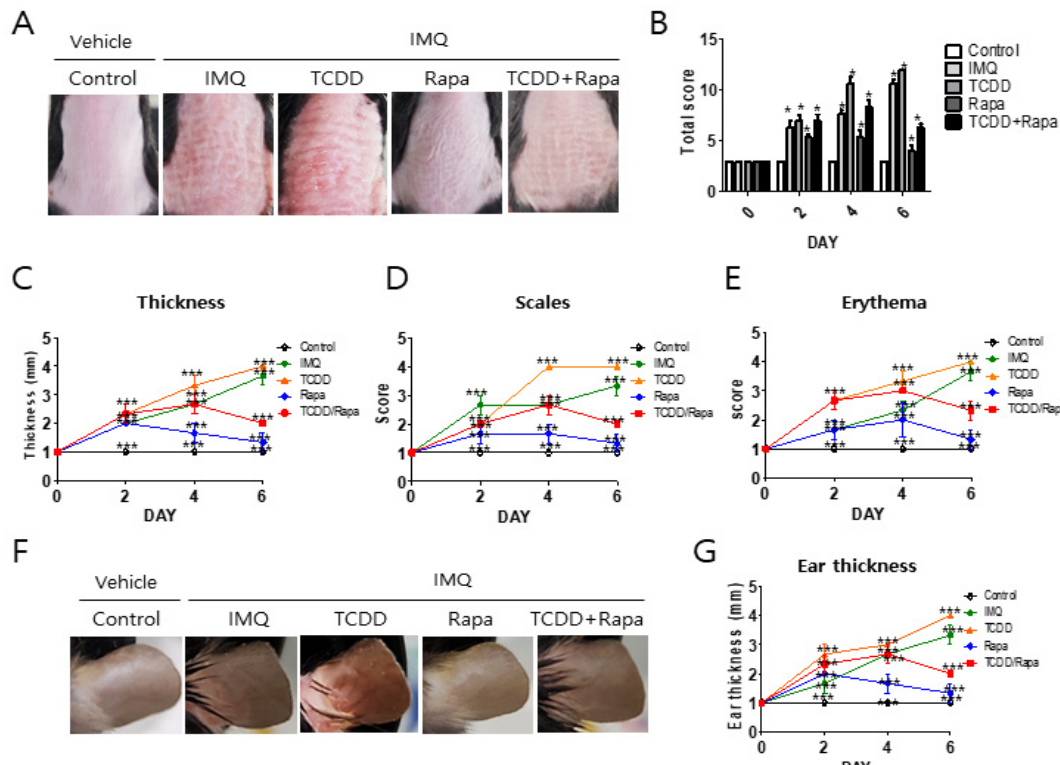
Figure 2. The effects of TCDD, rapamycin, and cotreatment with both on the clinical severity of imiquimod-induced pso- riatic mice. C57BL/6 mice were treated daily with vehicle control, IMQ, IMQ + TCDD, IMQ + Rapa, or IMQ + TCDD + Rapa applied on their shaved back skin and right ears ( n = 5 per treatment group). ( A ) Macroscopic presentation of dorsal skin of mice from the 5 treatment regimens. ( B ) The severity of inflammation on the back was assessed using a scoring system similar to the human Psoriasis Area and Severity Index (PASI) score. Thickness, scaling, and erythema of the back skin were scored “blindly” on a scale from 0 to 3 as follows: 0: none; 1: slight; 2: moderate; and 3: severe. ( C – E ) Detailed clinical disease score of thickness, scales, and erythema. Data represent mean ± standard deviation (SD). Statistical significance was determined by two-way repeated measures analysis of variance (ANOVA) with Tukey’s test. * p < 0.05; *** p < 0.001 compared with controls. ( F ) Macroscopic presentation of the right ear of mice from the 5 treatment regimens. ( G ) Assess- ment of ear skin thickness of the mice measured throughout the experiment. Statistical significance was determined by two-way repeated measures analysis of variance (ANOVA) with Tukey’s test. * p < 0.05; *** p < 0.001 compared with controls. IMQ: imiquimod, Rapa: rapamycin.